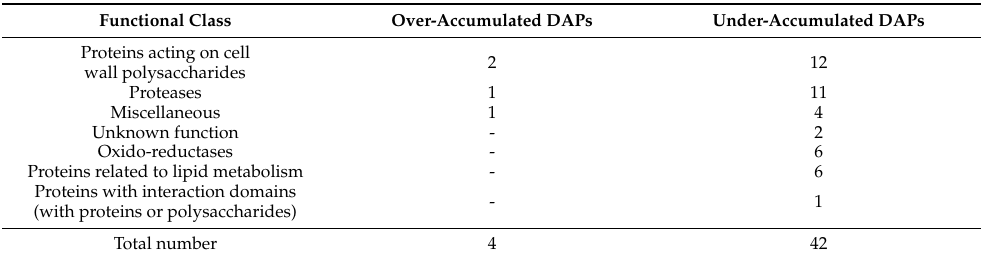
Table 2. DAPs for the 40 ◦ C treatment compared to the control and classified into their functional classes (according to the classification introduced in WallProtDB ).